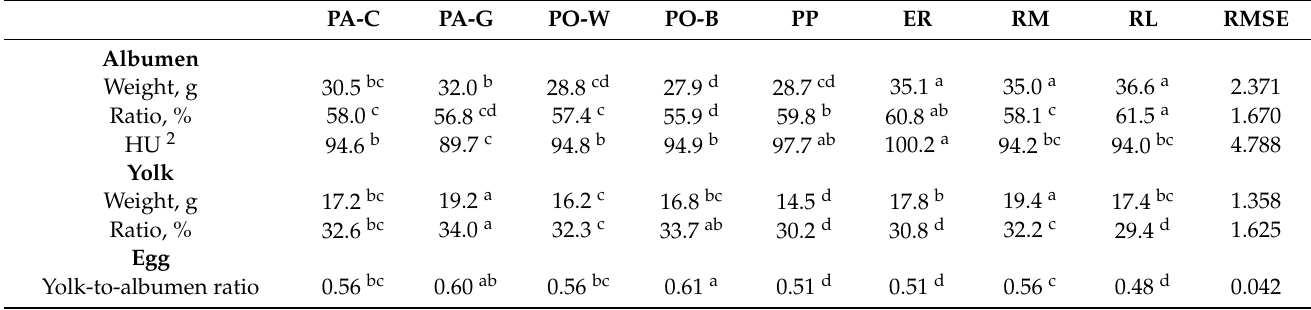
Table 3. Least squares means of albumen and yolk traits of the